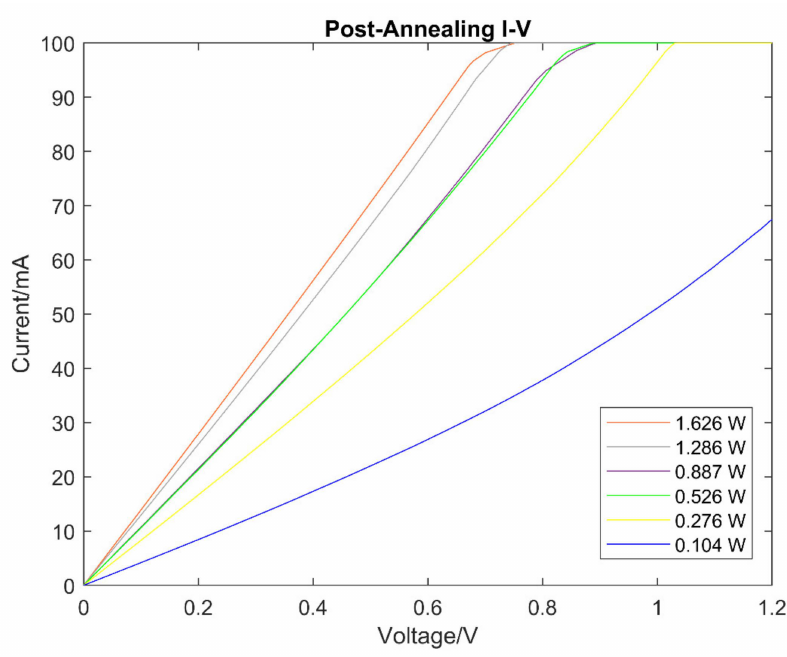
Figure 4. I-V curves of carbon powder samples post-annealing at different laser powers.